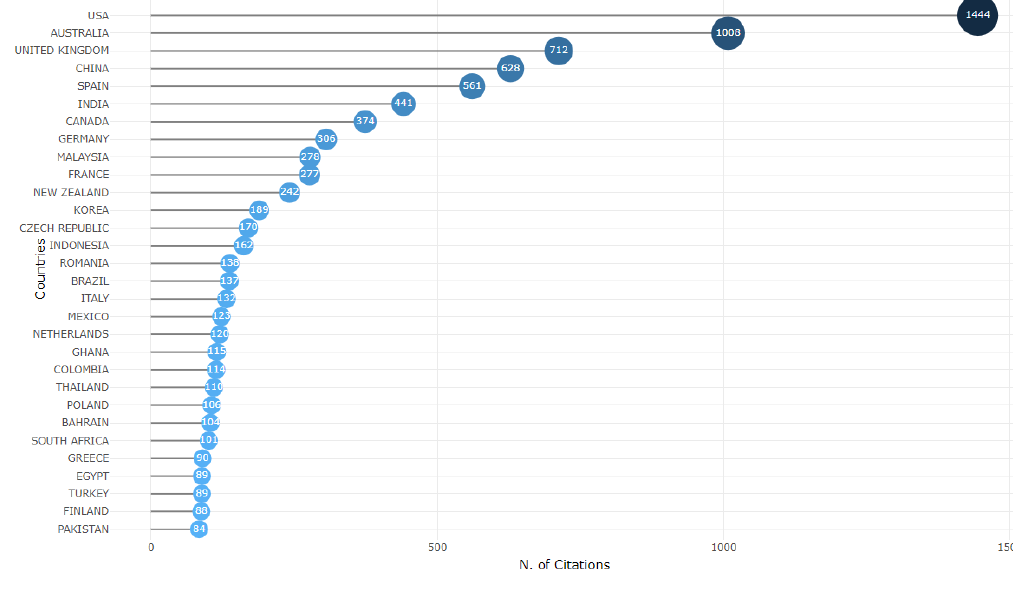
Figure 6. Top 30 Most Cited Countries by Research